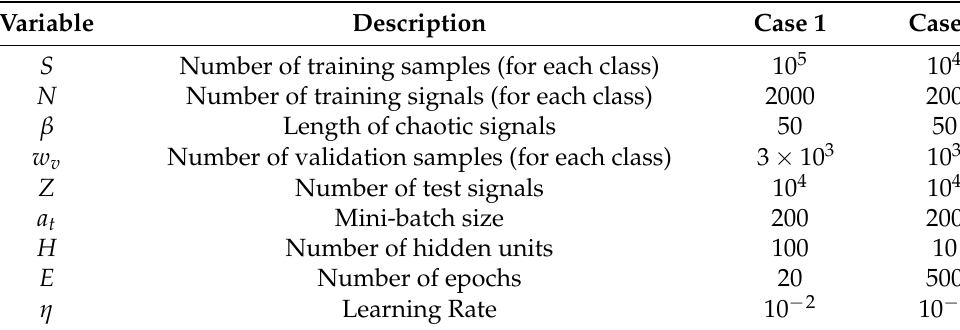
Table 1. List of the parameters.